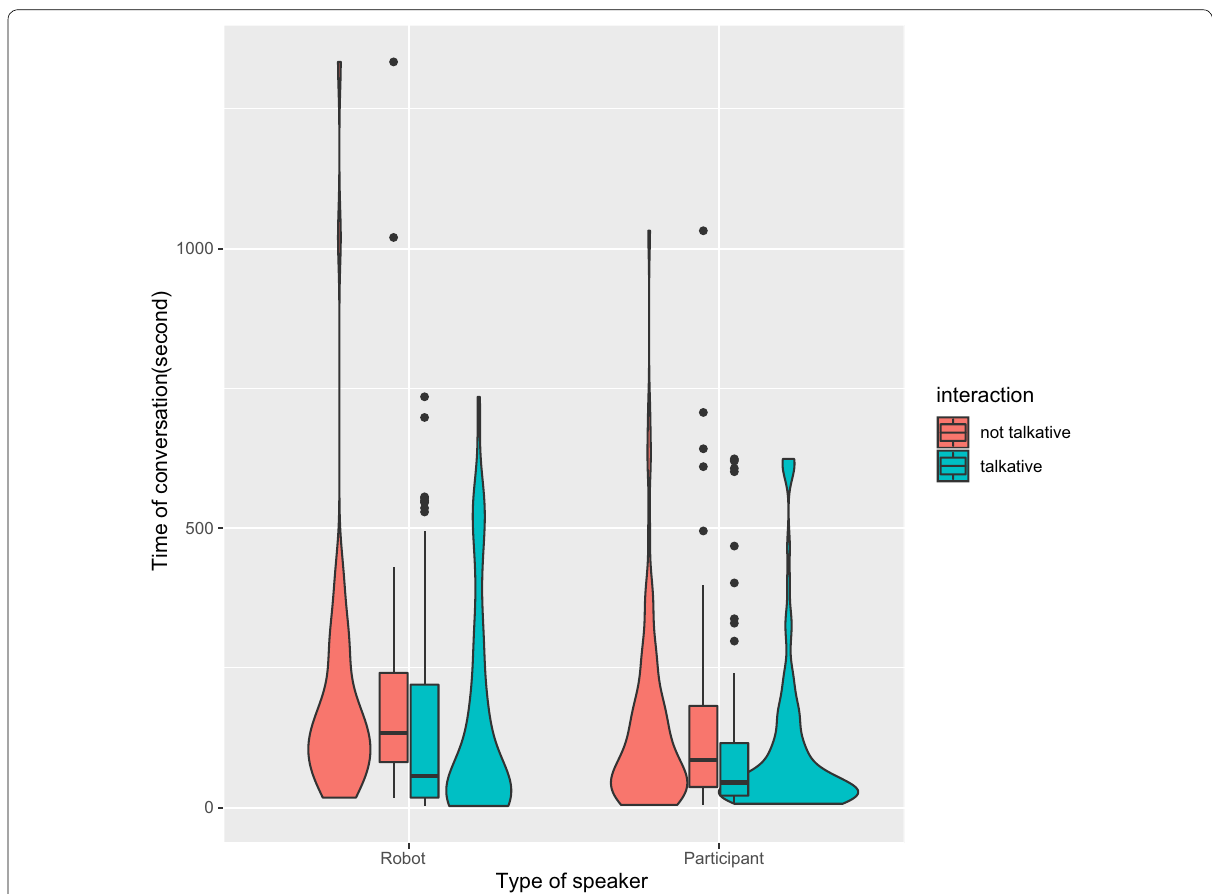
Fig. 8 Means and standard deviations of the robot’s and participants’ amount of conversations